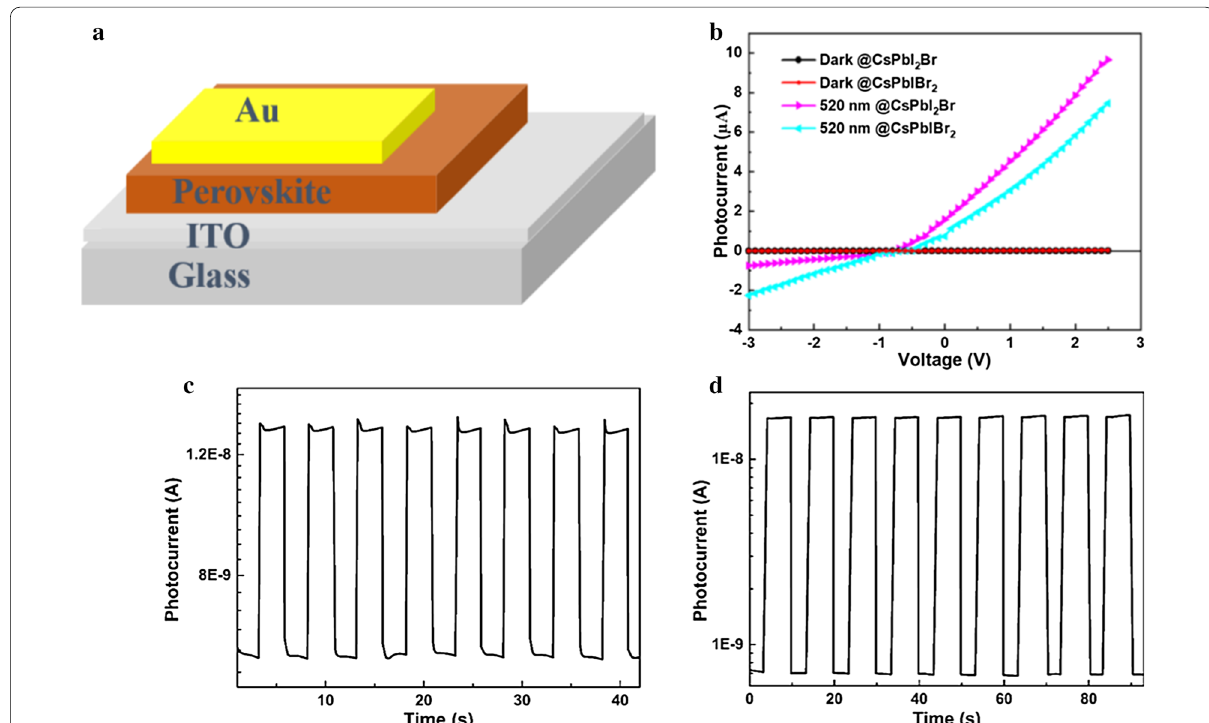
Fig. 3 Optoelectronic performance of CsPbI x Br 3 voltage characteristics of the CsPbI x Br 3 photoresponse of the CsPbI